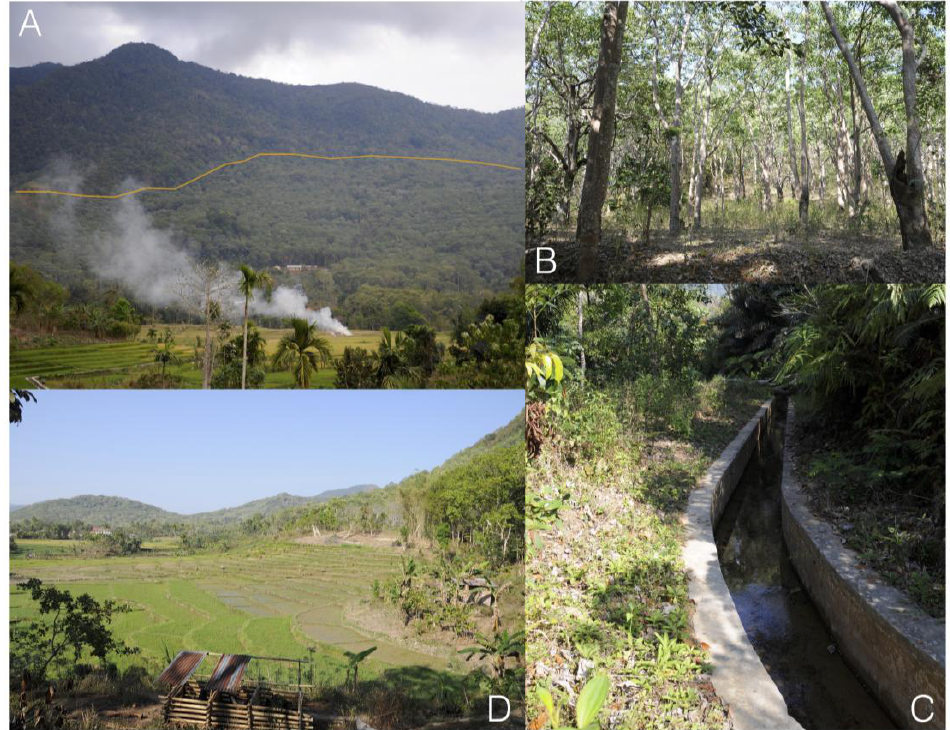
Figure 2. The landscape of Manggarai Barat. ( A ) Forested hillsides showing the boundary between the candlenut ( Aleurites moluccana ) agroforest and primary forest on steeper slopes. In the foreground are rice fields and a small fire burning crop residue; ( B ) A kemiri agroforest and mixed cropping gardens—home gardens—surround the rice fields; ( C ) an irrigation canal which the brings water from a small dam in the mountains to the rice fields in the valley; ( D ) irrigated rice fields and mixed production forest and homegardens (right).